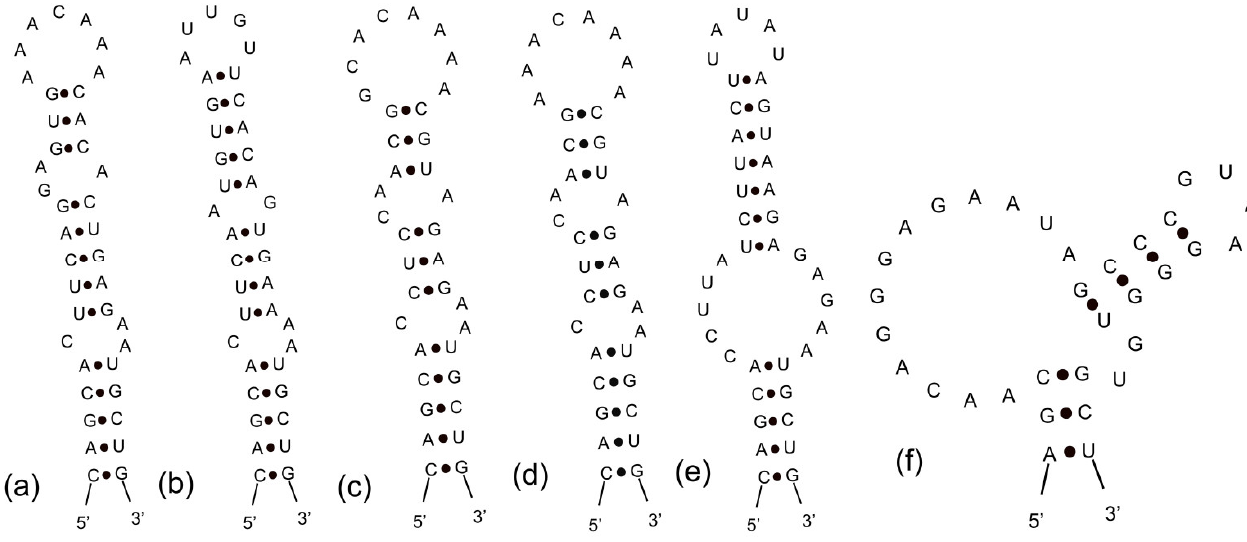
Figure 7. Box–B helix of Ancylothrix strains: ( a ) Ancylothrix rivularis WZU 0009, 0011, 0013, 0014; ( b ) Ancylothrix rivularis 7PC, 8PC, 9PC; ( c ) Ancylothrix terrestris 10PC, 13PC; ( d ) Ancylothrix terrestris WZU 0153, 0154; ( e ) Ancylothrix terrestris 11PC; ( f ) Ancylothrix terrestris 12PC.